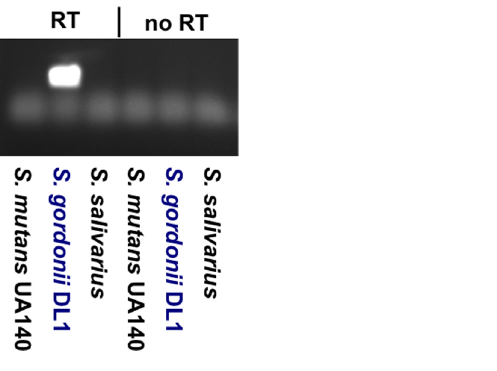
Figure 2. RT-PCR of cDNA from selected oral streptococci. RNA was isolated from the H 2 O 2 producer S. gordonii DL1 and expression of spxB compared to H 2 O 2 -non-producer S. mutans UA140 and S. salivarius . RT - PCR was performed for 28 cycles.